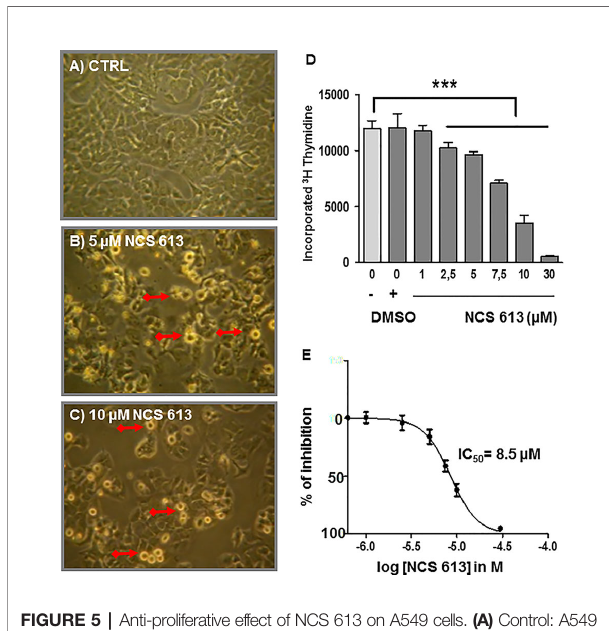
FIGURE 5 | Anti-proliferative effect of NCS 613 on A549 cells. (A) Control: A549 cells display rapid proliferation rate toward con fl uency. (B, C) A549 cells treated with either 5 µM or 10 µM NCS 613 for 48 h results in lower density and higher apoptosis. Plates are representative of three independent experiments; (D) Bar histogram showing [ 3 H]-thymidine incorporation into DNA. Gradual (2.5 – 30 µM) NCS 613 treatment signi fi cantly decreases A549 cells proliferation; (E) Concentration dependent inhibition curve displaying the antiproliferative effects of NCS 613 from which an IC 50 value of 8.5 µM was calculated. Unpaired Student ’ s t -test. Mean ± SEM. ***p < 0.001.